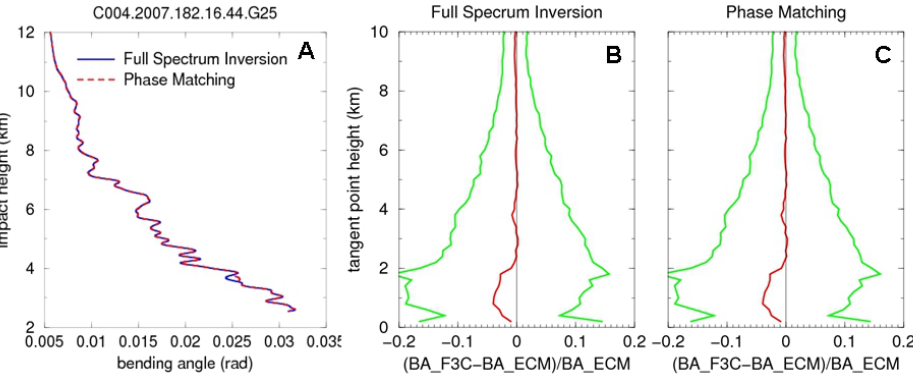
Fig. 4. Panel A : comparison of bending angle profiles derived by FSI and PM for one occultation; panels B and C : statistical comparisons of the bending angles derived by FSI and PM to ECMWF-derived bending angles for 1 day (red: mean difference, green ± standard